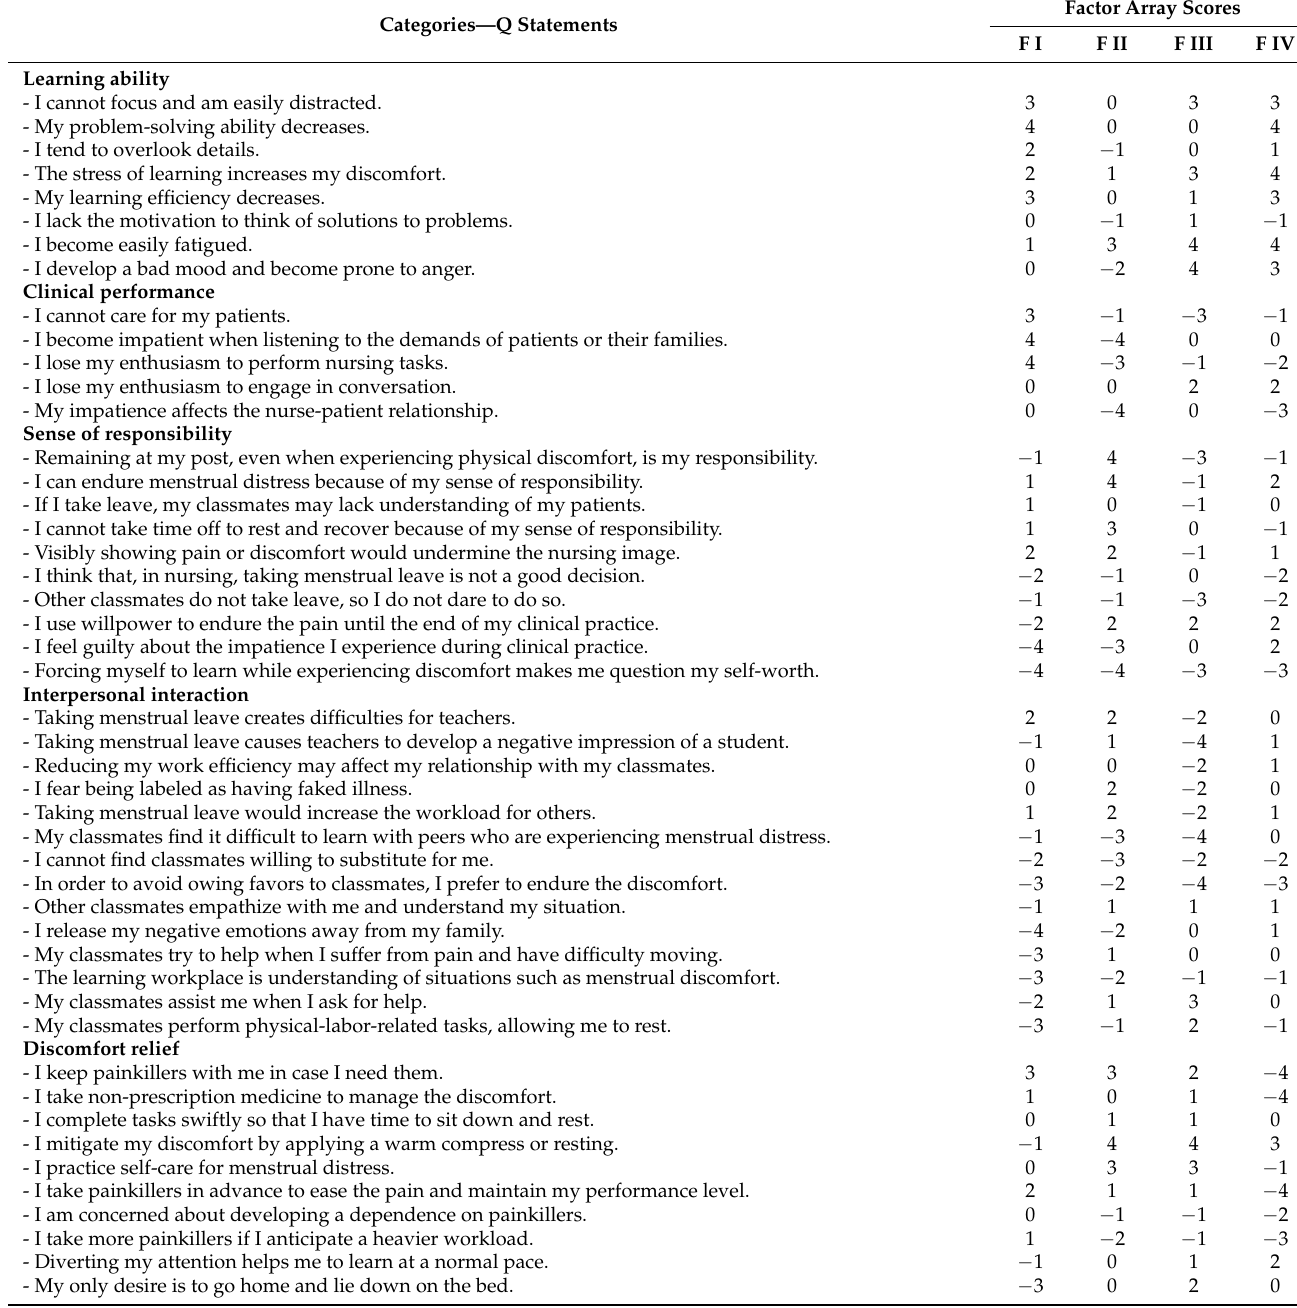
Table 1. The 47 Q-statements and the factor array scores of the four